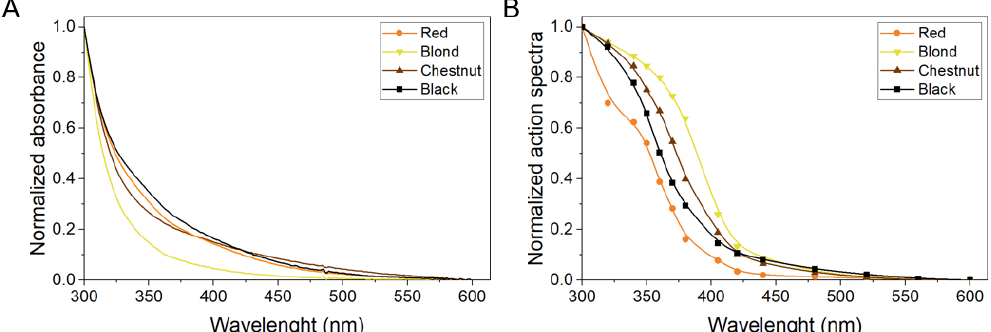
Figure 7. Normalized UV-Vis absorption spectra ( A ) and action spectra of singlet oxygen photogeneration ( B ) for melanin nanoaggregates from different hair samples.